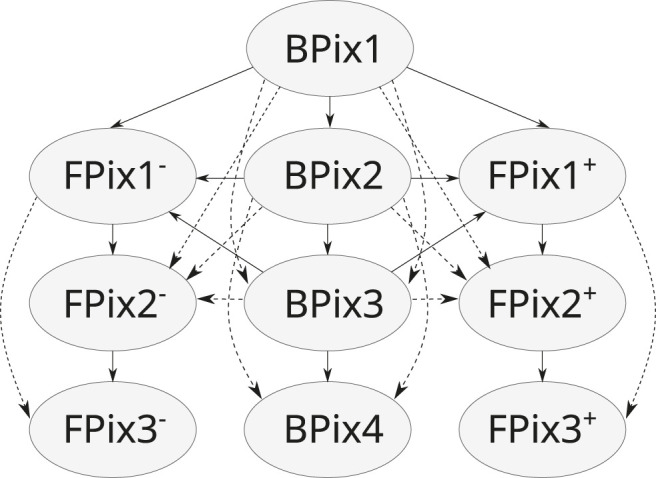
Combinations of pixel layers that can create doublets directly (solid arrow), or by skipping a layer to account for geometrical acceptance (dashed arrow).